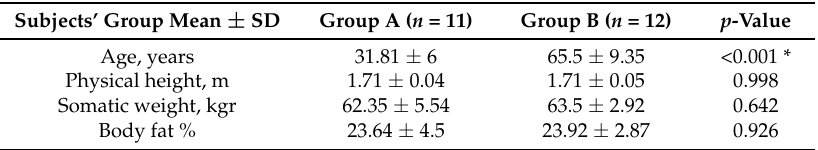
Table 1. Subjects’ anthropometric characteristics.